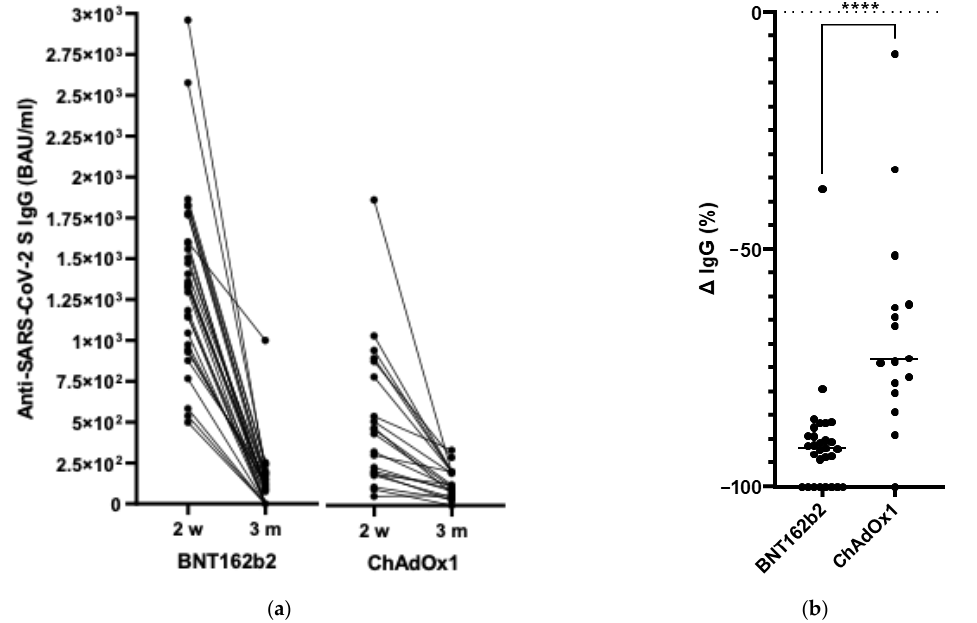
Figure 3. The anti-SARS-CoV-2 spike protein IgG antibody waning among teachers vaccinated with BNT162b2 or ChAdOx1 ( a ) from two weeks to three months after the second vaccination second dose, and ( b ) presented as a percentage change at three months post vaccination. ****— p <